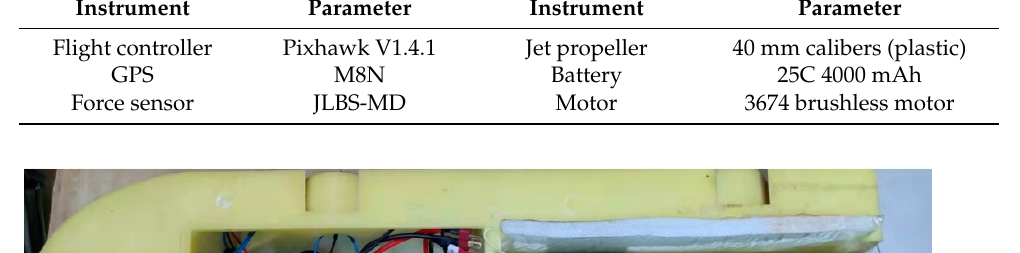
Figure 18. Diagram of test model structure. 1—car body; 2—sensor; 3—slideway; 4—power sys- tem. Table 7. Parameters of model test instruments. Table 7. Parameters of model test instruments.